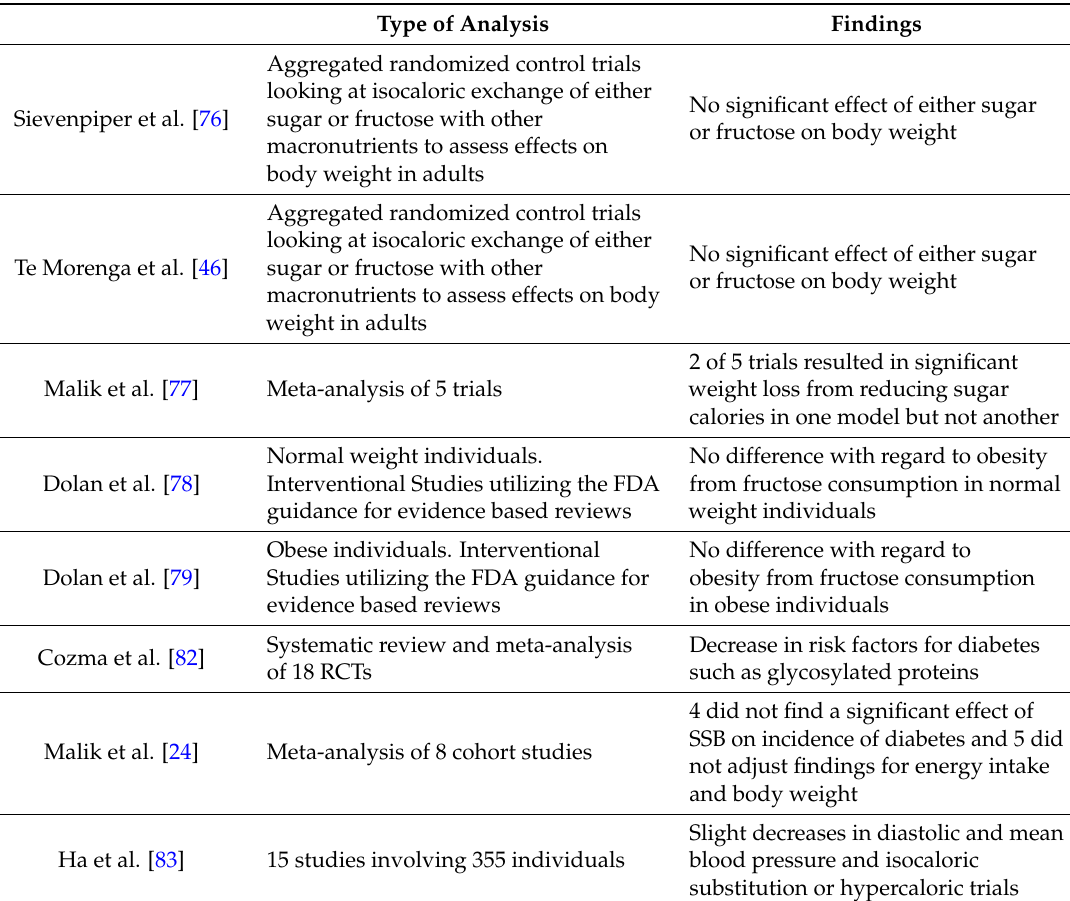
Table 2. Systematic Reviews and Meta-analyses